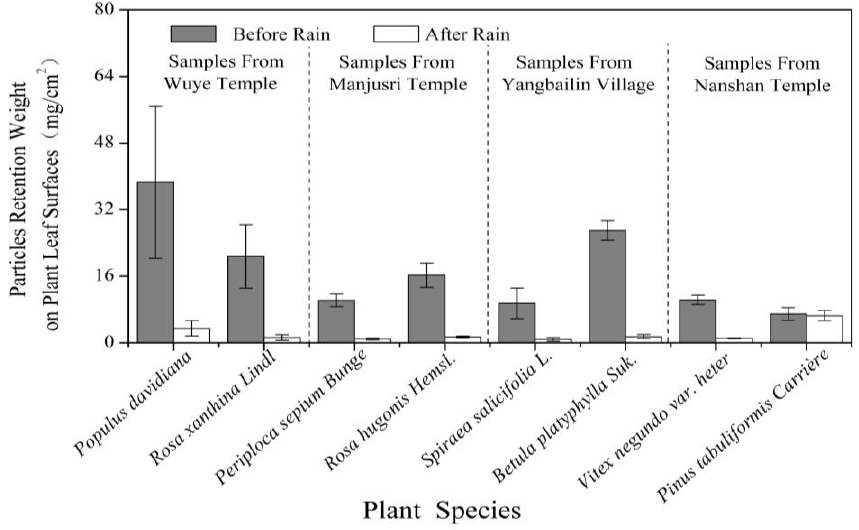
Figure 2. The particle retention quality of different plant leaves.